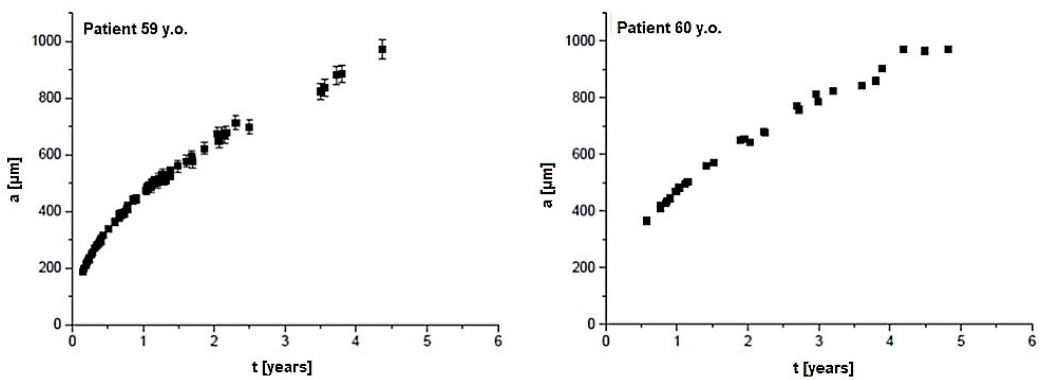
Figure 7. The dependence of the radius value of mineral grains built from hydroxyapatite-like mineral (HAP) from the growth time for two cases of the yellow ligaments of elderly patients (stenosis group)